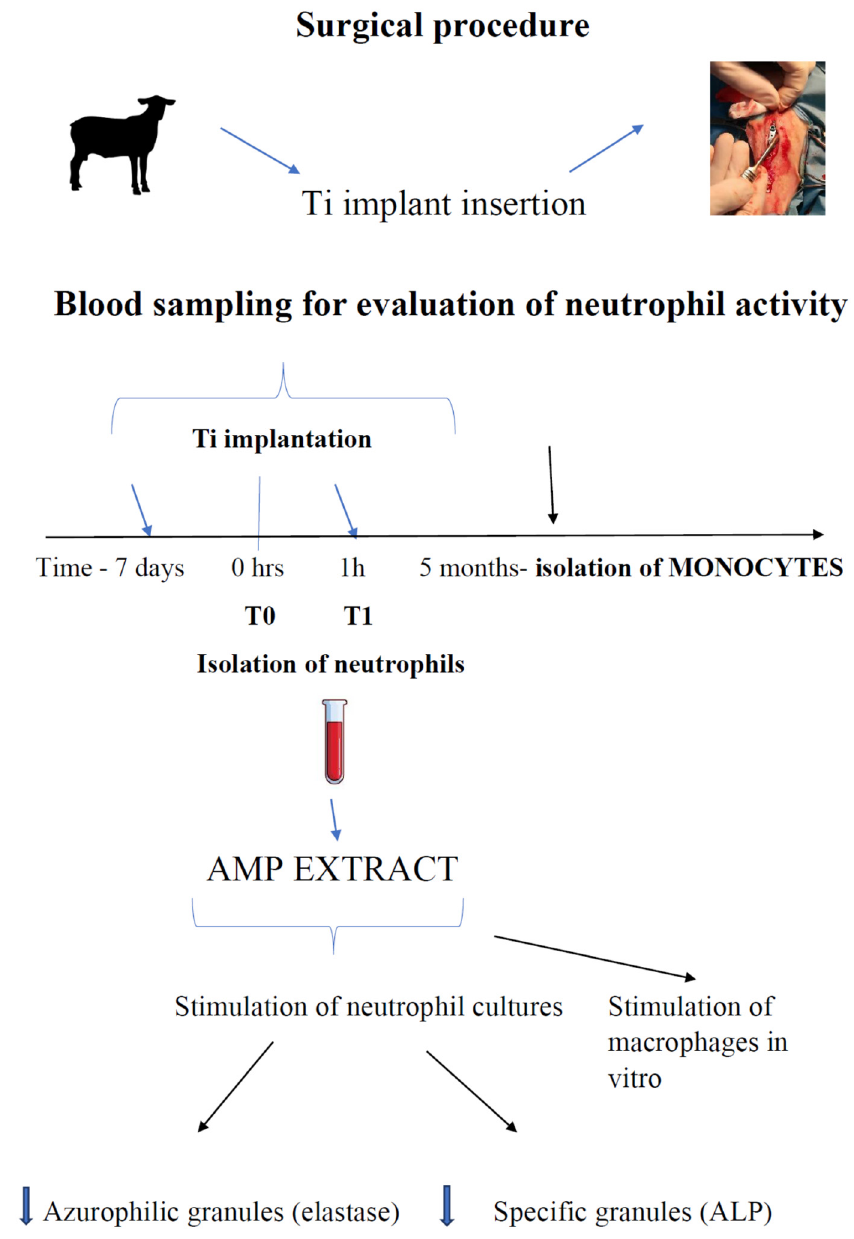
Figure 2. Preparation of ANE (AMP extract) and timeline of blood sampling for isolation of leukocytes from circulating blood.